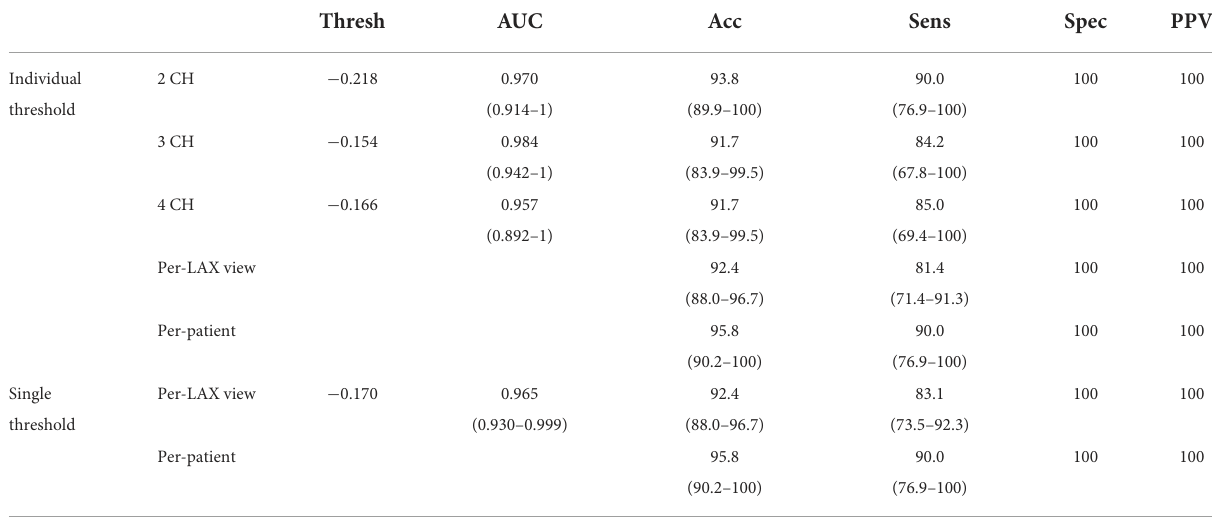
TABLE 2 Use of training cohort for identification of LS cutoffs for WMA detection using the curve fitting approach.